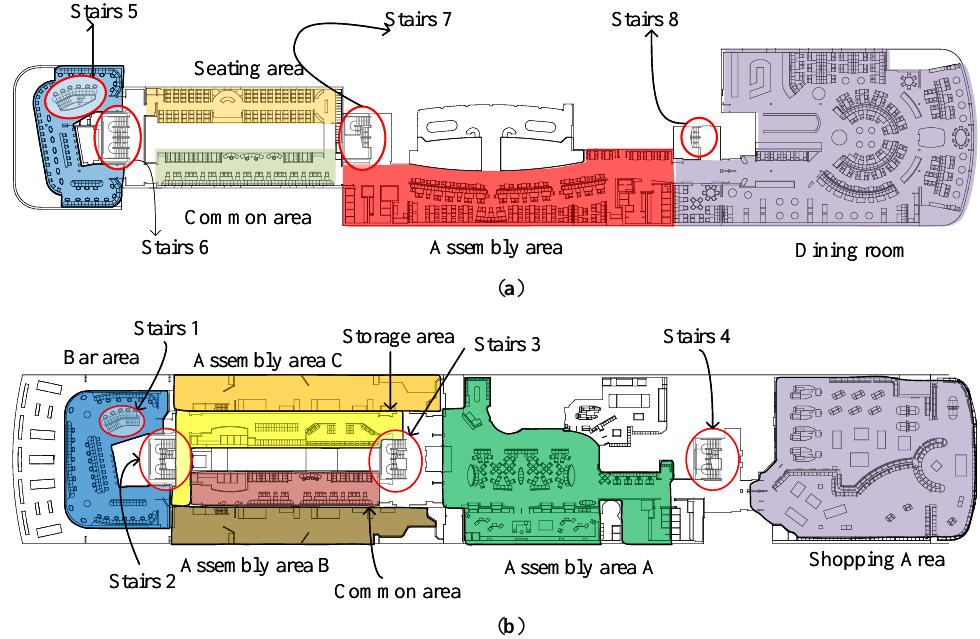
Figure 2. The layouts of the model with Anylogic: ( a ) first deck layout of cruise ship; ( b ) second deck layout of cruise ship.